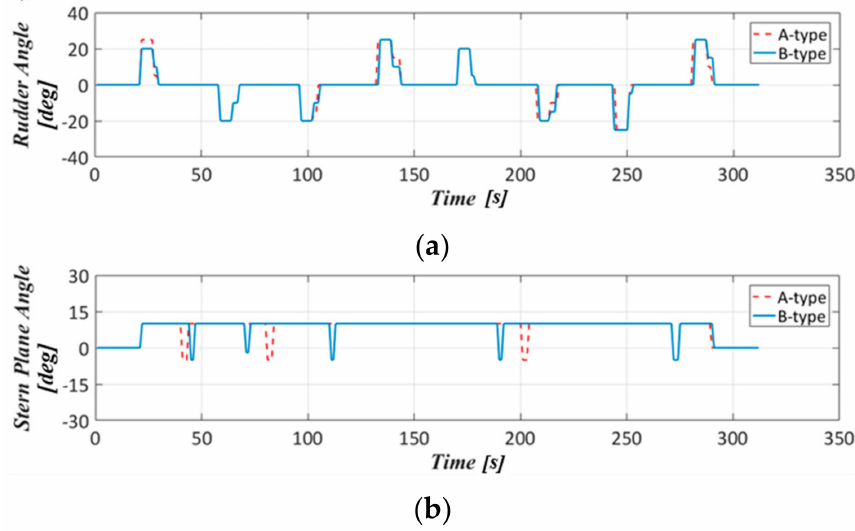
Figure 26. Time series of ( a ) rudder angle, and ( b ) stern plane angles for the A-type and B-type controllers, respectively.